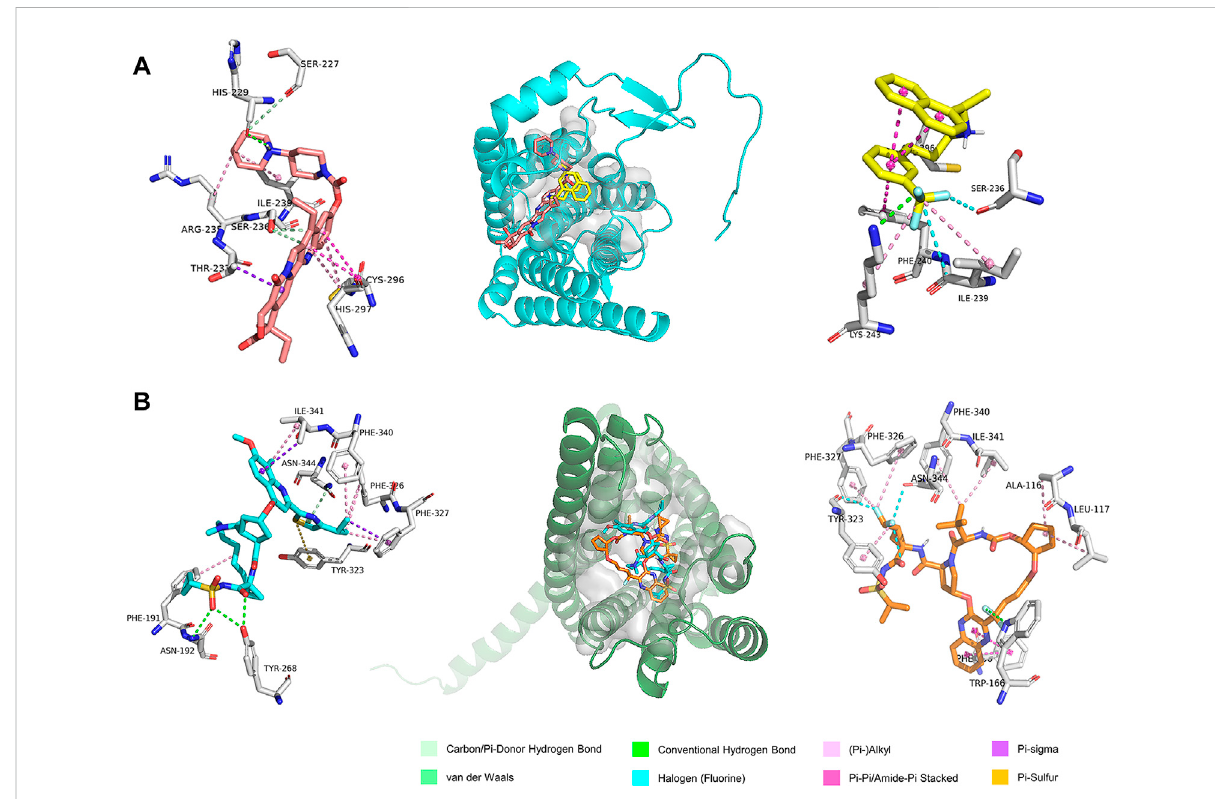
FIGURE 5 The predicted binding modes of the ligands with (A) GPR160 and (B) CRHR2 at the ligand binding pocket (dashed box). Different ligands are represented by different colored sticks, salmon: Irinotecan, yellow: Cinacalcet, orange: Simeprevir, and cyan: